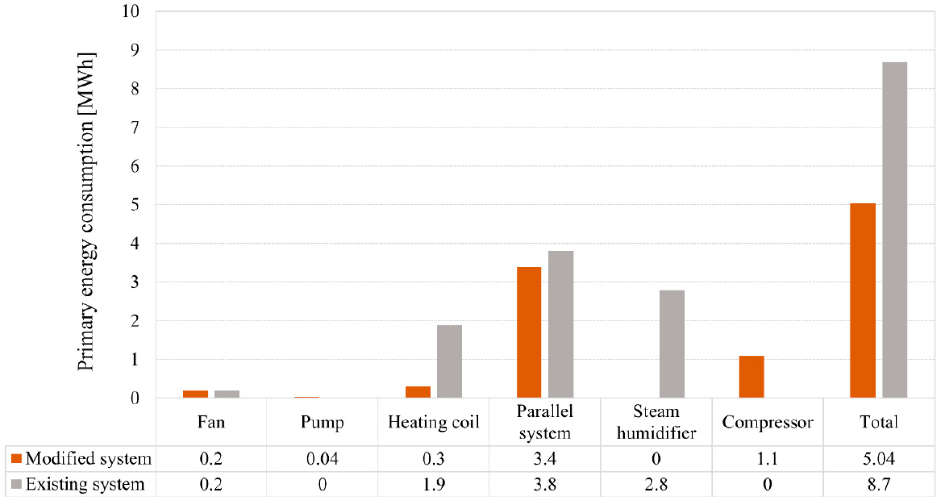
Figure 14. Comparison of primary energy consumptions.